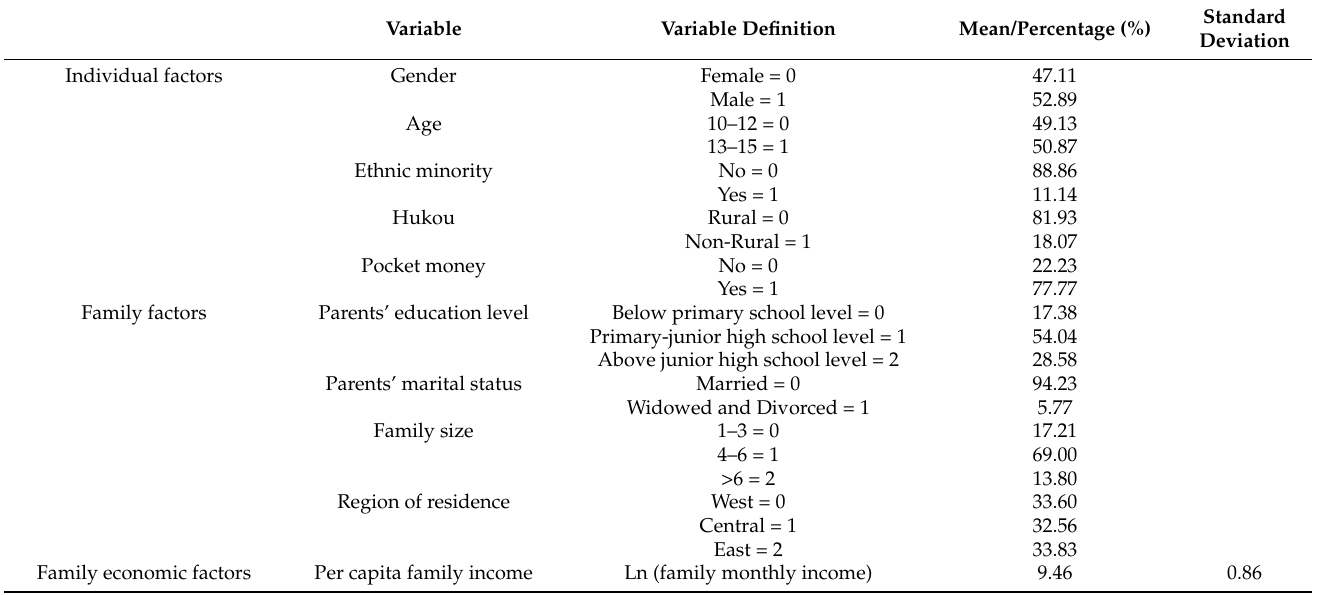
Table 2. Descriptive statistics.